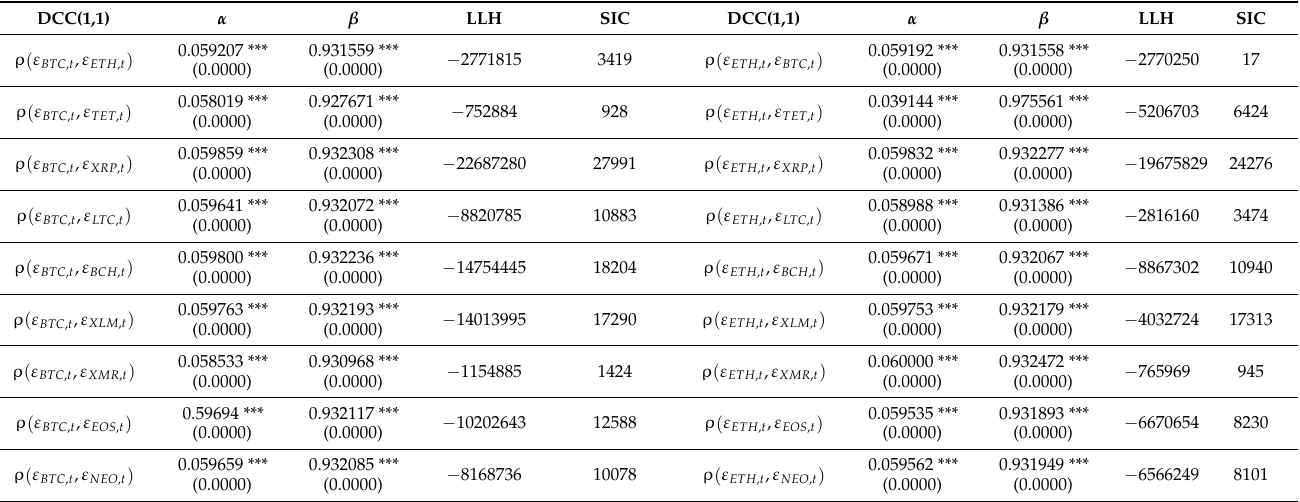
Table 13. DCC(1,1) models between the return indices of Bitcoin and Ethereum and the other cryptocurrencies’ return indices for the full period.